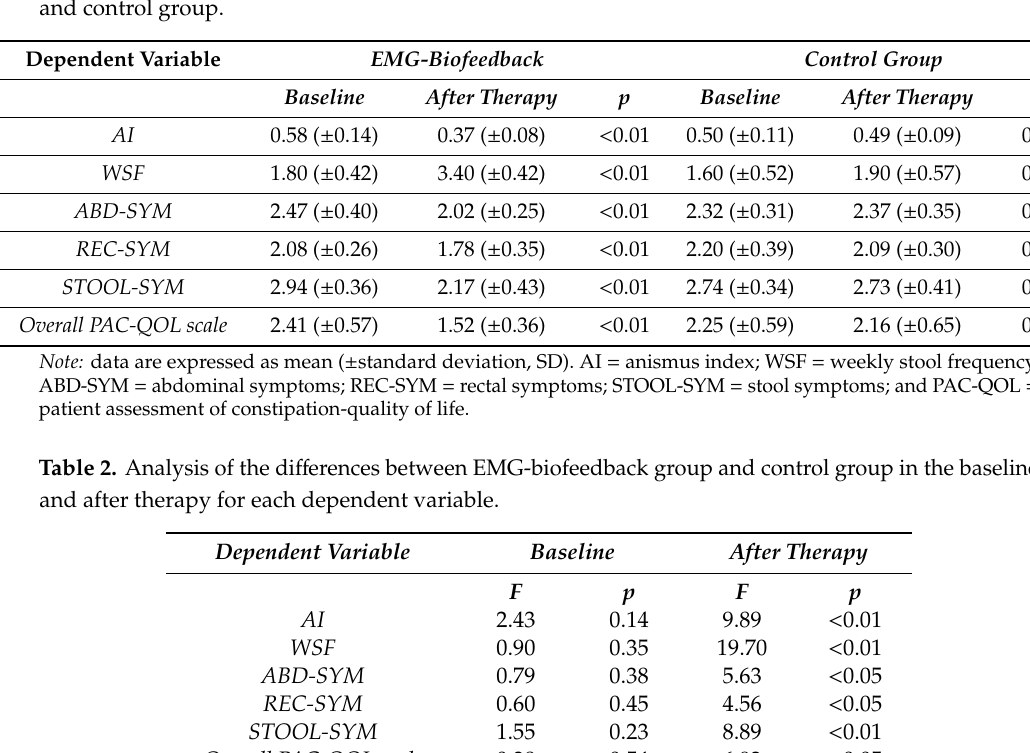
Table 2. Analysis of the differences between EMG-biofeedback group and control group in the baseline and after therapy for each dependent variable.